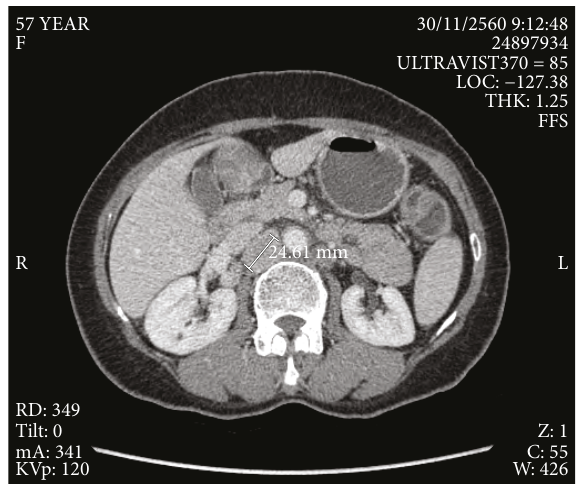
Figure 2: Abdominal CT scan at the time of diagnosis demonstrated matted paraaortic nodes.